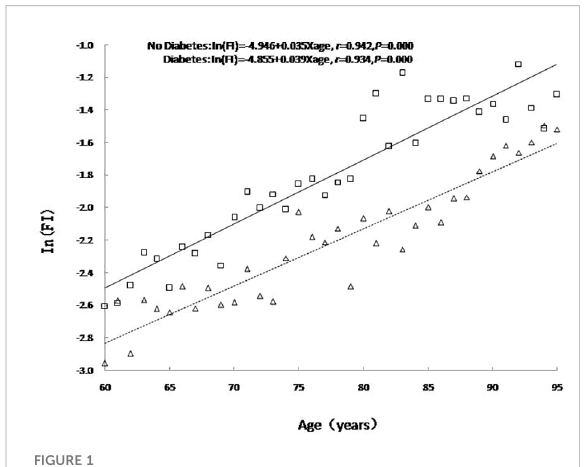
FIGURE 1 The relationship between age and the mean value of FI. No diabetes: triangle and dashed line; Diabetes: square and solid